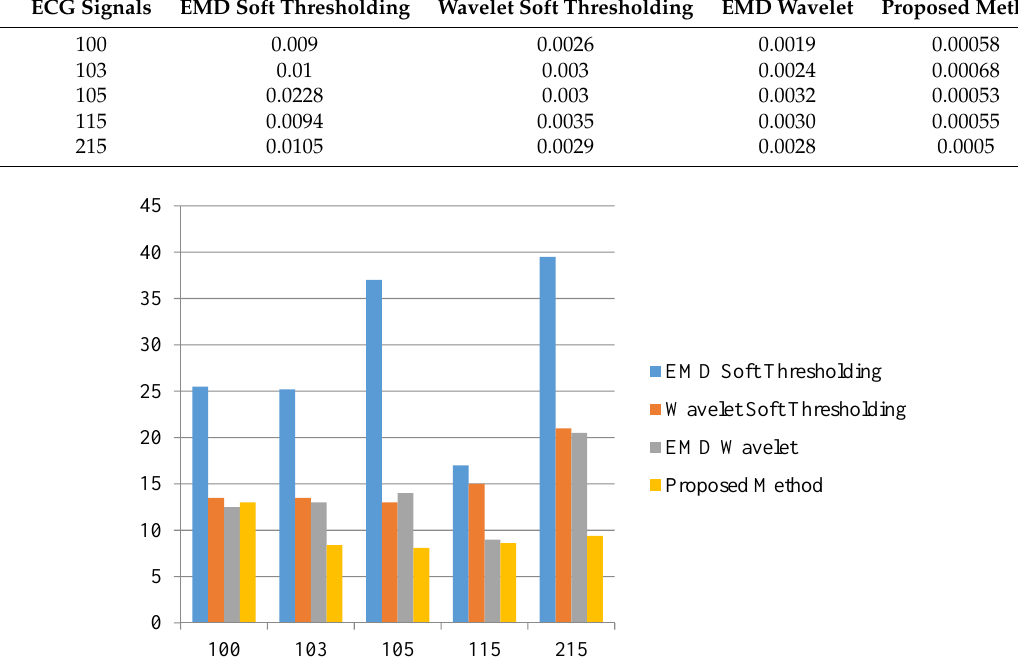
Figure 10. Comparison of the PRD(%) obtained by using different de-noising